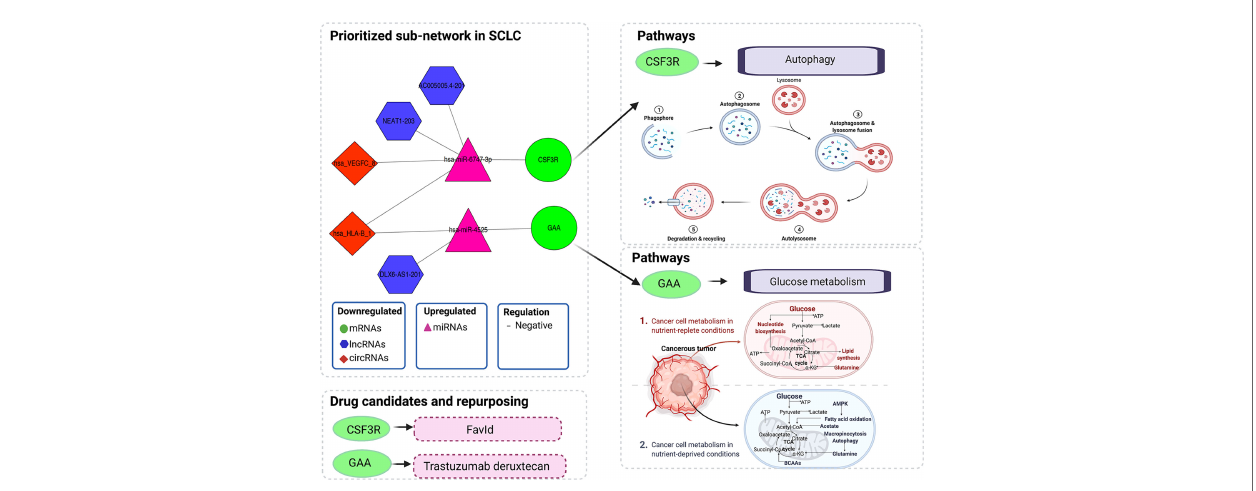
FIGURE 5 | Illustration of multi-omics – based prioritisation of the ceRNA subnetwork, drug candidates and pathways. ATP, adenosine triphosphatase; AMPK, AMP- activated protein kinase; BCAAs, branched-chain amino acids; CoA, coenzyme A; ceRNA, competitive endogenous; RNA; circRNA, circular RNA; CSF3R, colony- stimulating factor 3 receptor; GAA, acid alpha-glucosidase; lncRNA, long noncoding RNA; miRNA, microRNA; mRNA, messenger RNA; SCLC, small cell lung cancer; TCA, tricarboxylic